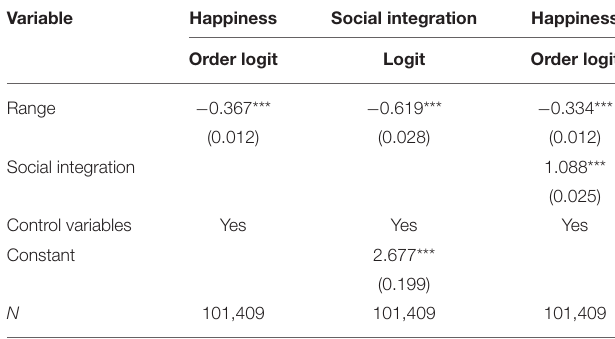
TABLE 6 | Mediating effect of social